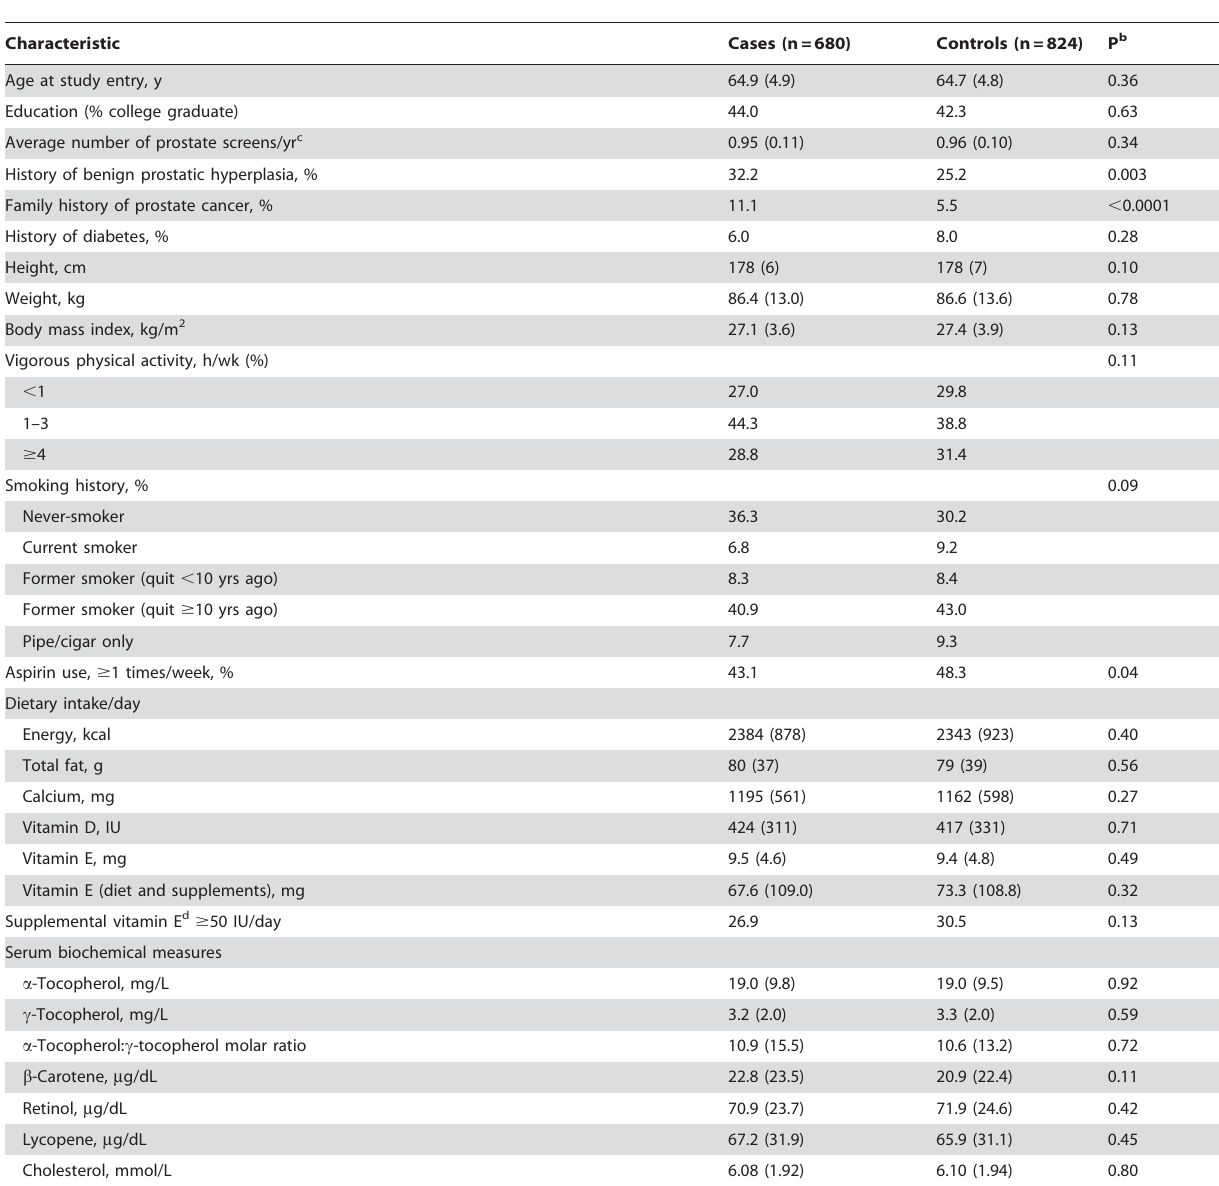
Table 1. Selected baseline characteristics by case or control status a , PLCO